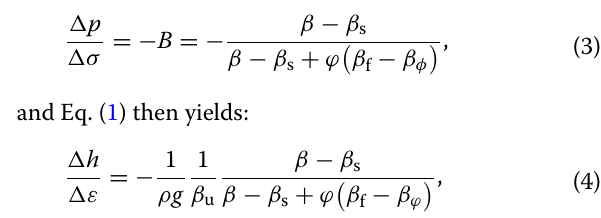
Table 2 Theoretical amplitudes and phase shifts of the M equilibrium tide, oceanic tide loading effect, and total tidal strain, calculated using GOTIC2, and average responses in observed groundwater level, calculated using BAYTAP-G Equilibrium